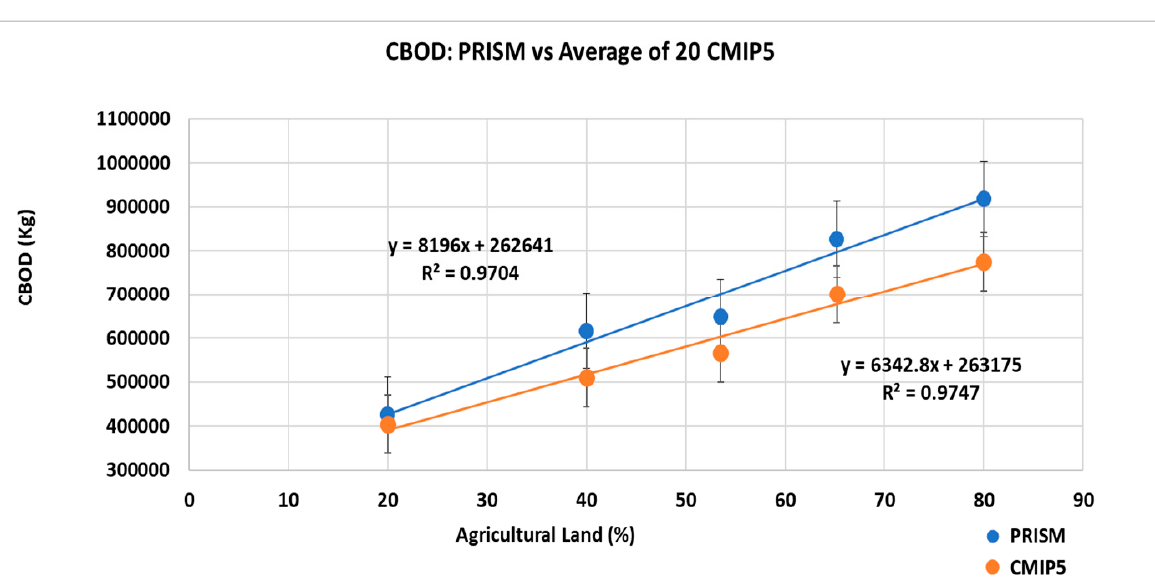
Figure 9. PRISM vs. 20 CMIP5 GCMs for CBOD.